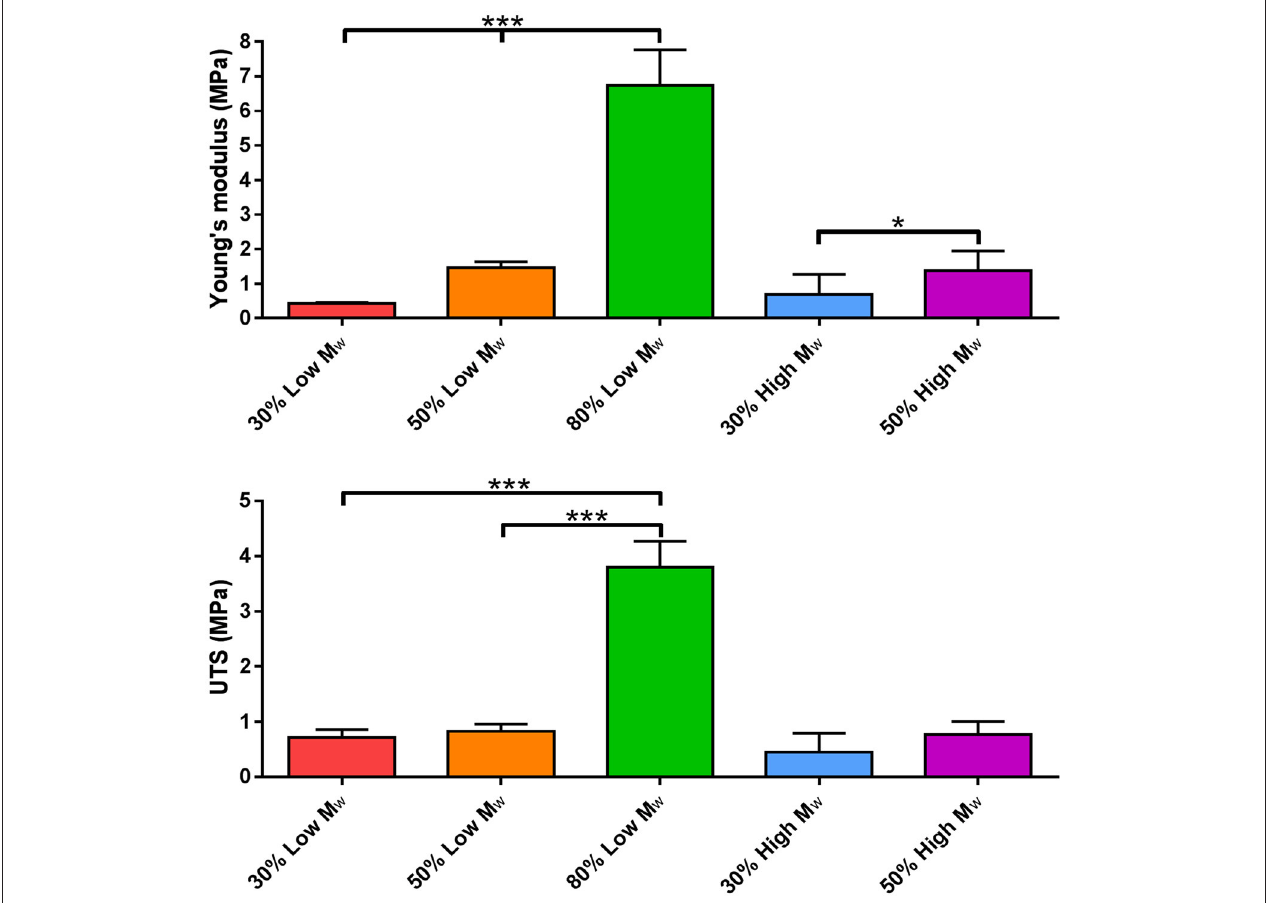
FIGURE 9 | Young’s modulus and ultimate tensile strength (UTS) of Low and High M w and varied DM PGS-M ( n = 3). The degree of significance is indicated as *** P ≤ 0.001, ** P ≤ 0.01 and * P ≤ 0.05.